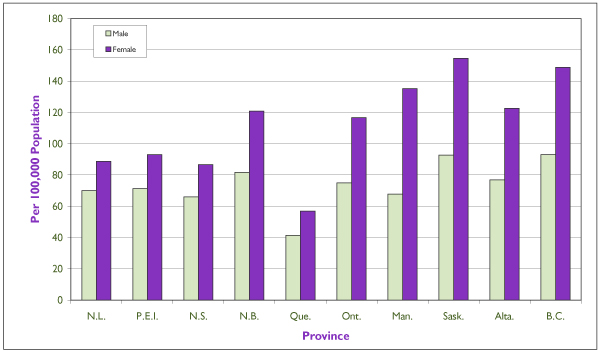
Age-standardized hospitalization rates for suicide attempts,* by sex and province, 1998 Source: Hospital Morbidity Database, 1998–1999 (Health Rep 2002;13(2))